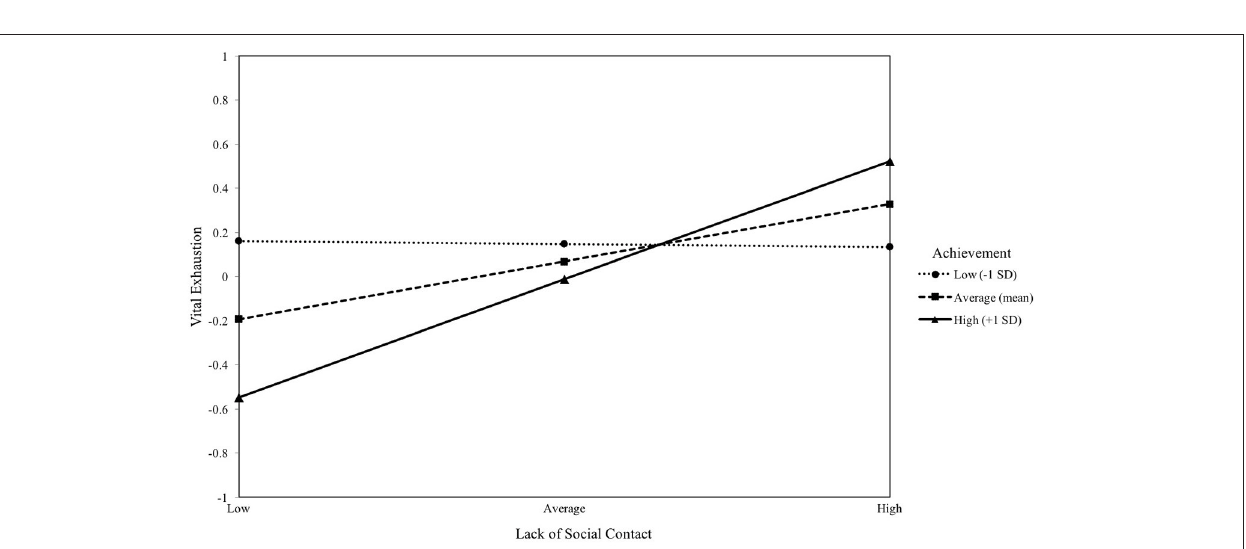
FIGURE 5 | The moderating effect of implicit achievement motive on the association between lack of social contact and vital exhaustion. Simple slopes of lack of social contact predicting vital exhaustion for 1 SD below the mean of achievement, at the mean of achievement, and 1 SD above the mean of